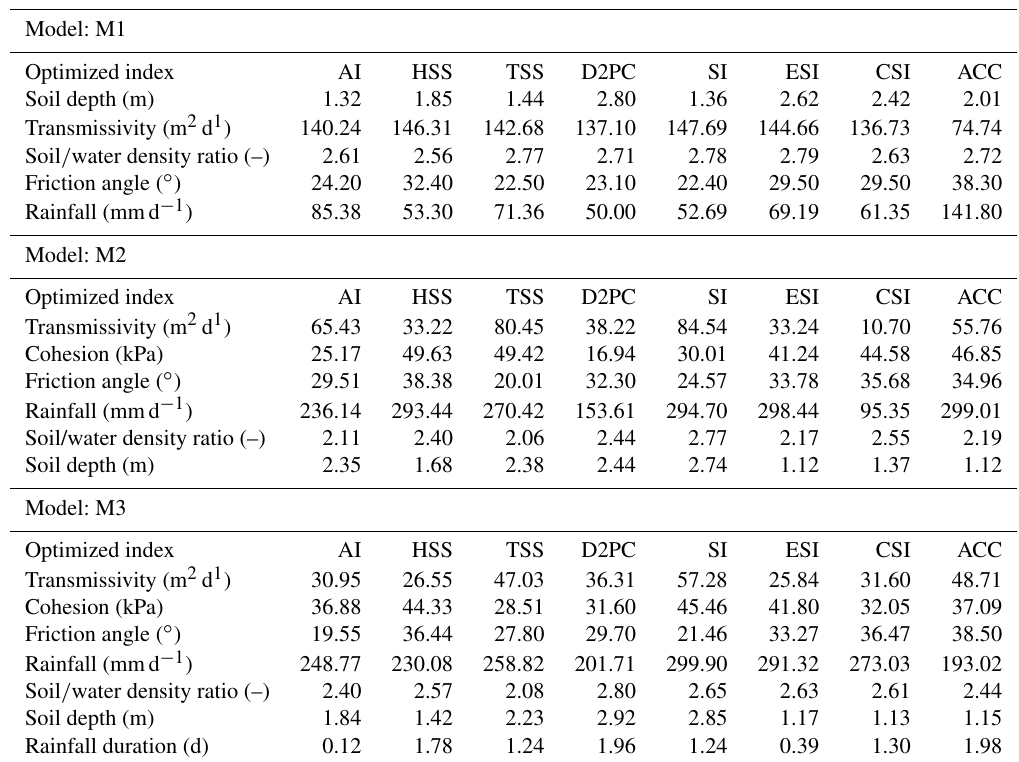
Table 3. Optimal parameter sets output of the optimization procedure of each GOF index in turn. Results are presented for each model (M1, M2, and M3).